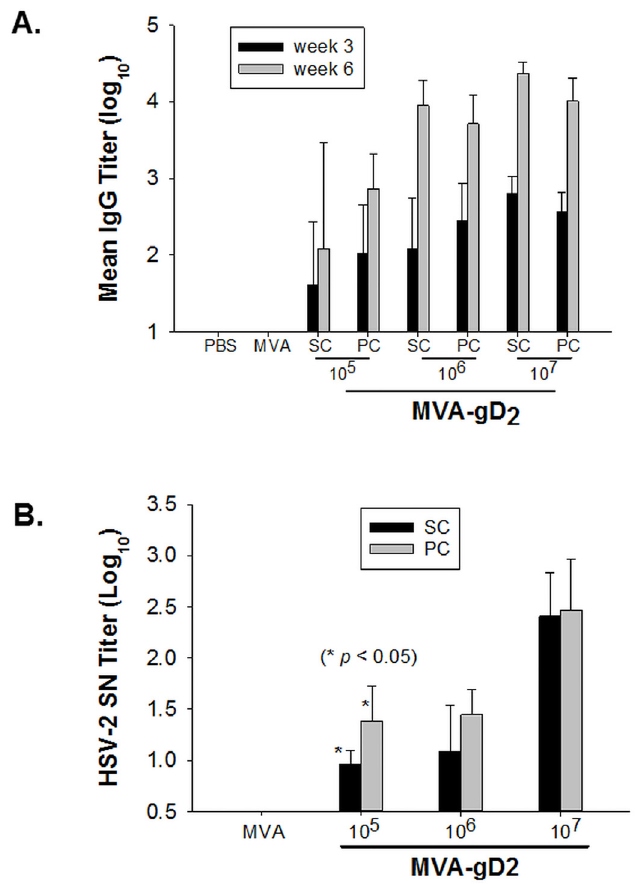
Fig 2. Antibody response to MVA-gD2 inoculated by the subcutaneous or percutaneous route. Groups of mice were vaccinated with MVA-gD2 at doses of 10 5 , 10 6 , or 10 7 pfu, on a prime-boost schedule, with an interval of three weeks between the two vaccinations. A control group was vaccinated with 10 7 pfu of MVA subcutaneously. Antisera obtained from mice 3 weeks after the first vaccination (week 3) and 3 weeks after the second vaccination (week 6) were tested for HSV-2 gD-specific IgG by ELISA. The log 10 values of the mean IgG titers are shown in A . The week-6 antisera were also tested for the neutralization of HSV-2 infectivity in Vero cells. Mean serum neutralization (SN) antibody titers are shown in B . Error bars represent standard deviation.